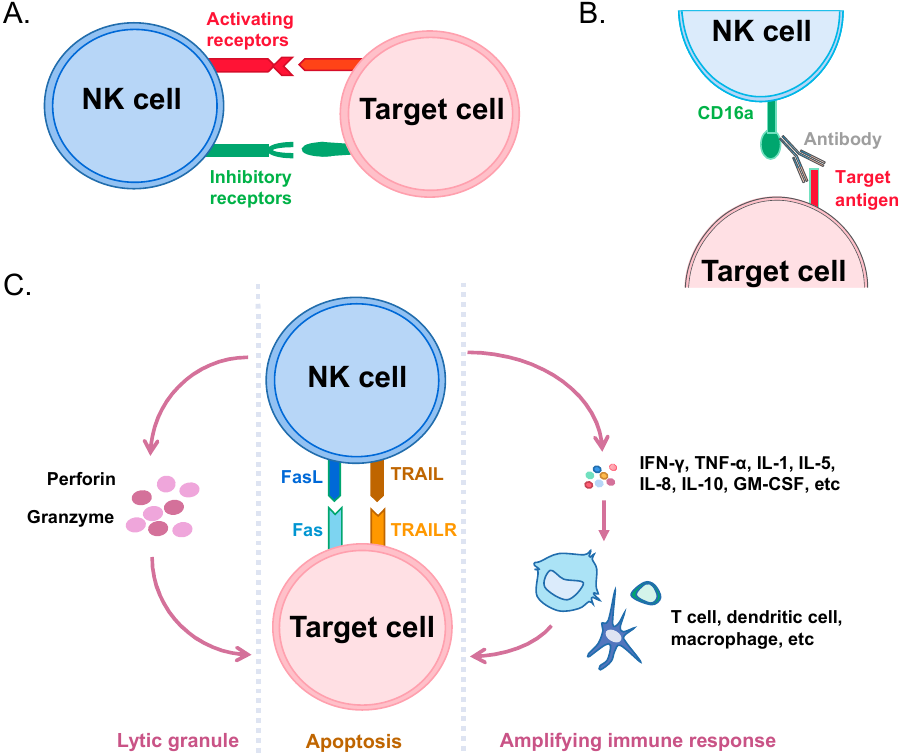
Figure 2. Cartoon illustration of NK cell activation and cytotoxicity. ( A ) NK cell can bind to target cell through both activating receptors (red) and inhibitory receptors (green). Its status is dependent on which signaling is dominant. ( B ) NK cell can also be activated through its CD16a binding to a cell-bound antibody. ( C ) Activated NK cells kill target cells through the release of lytic granules and FasL-Fas/TRAIL-TRAILR axis. NK cells also recruit other immune cells through the cytokine release to amplify the immune response against target cells.